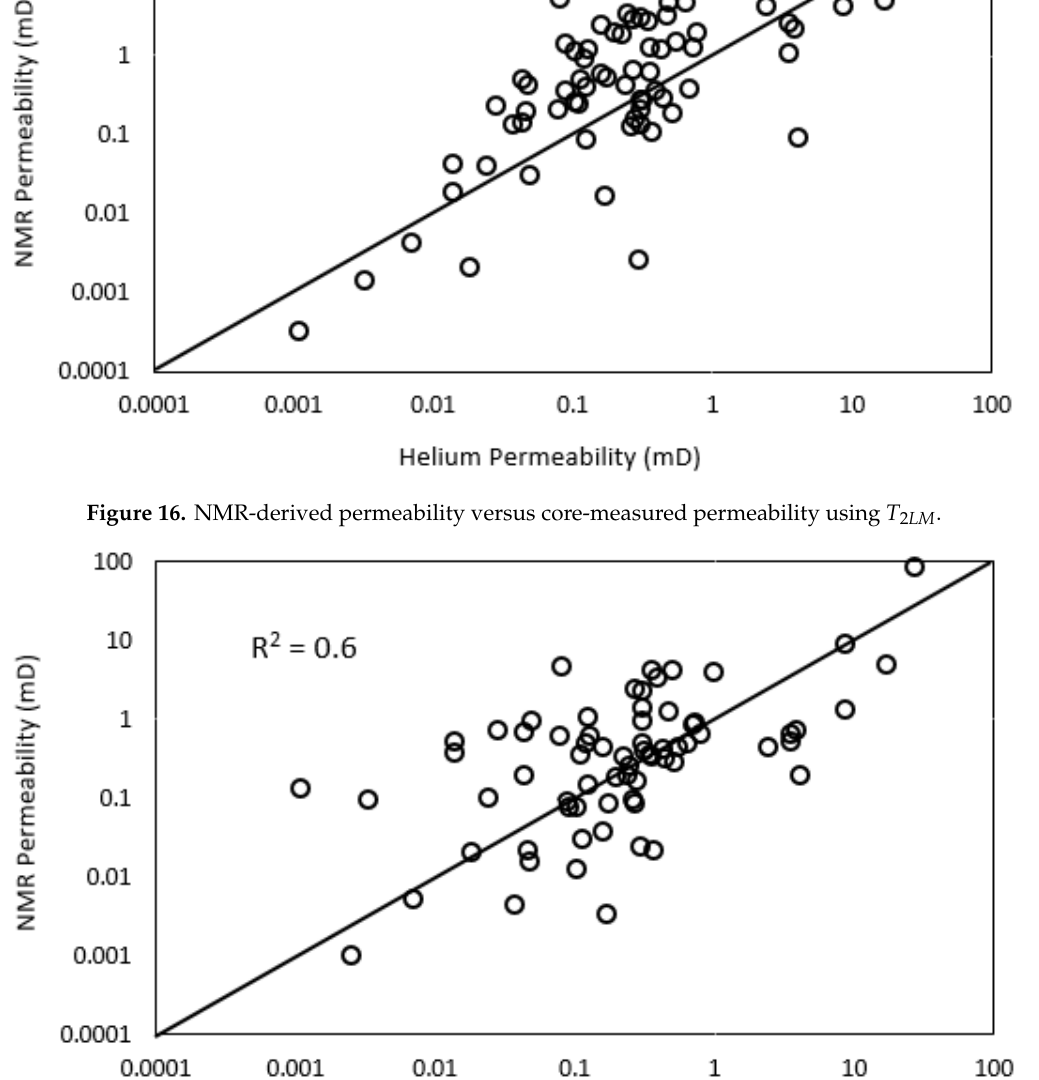
Figure 17. NMR-derived permeability versus core-measured permeability using 𝑇 2 at 99% water